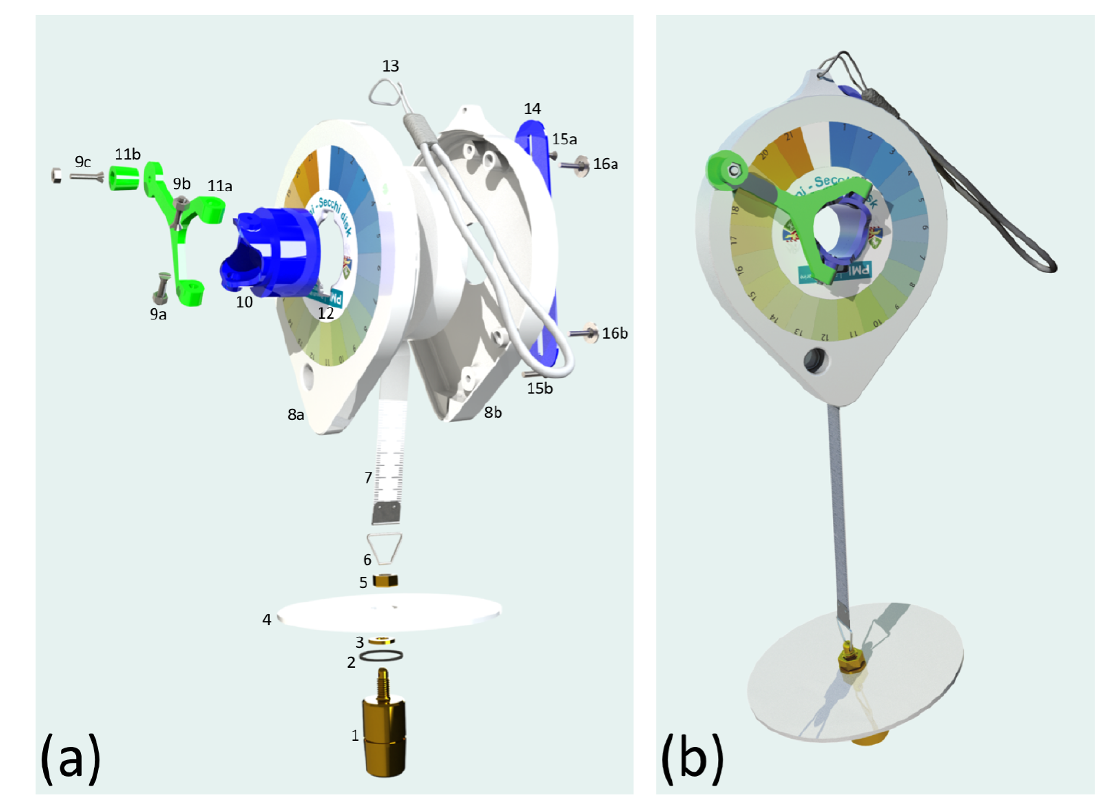
Figure 2. An exploded drawing ( a ) and rendering ( b ) of the mini-Secchi disk. Numbers refer to components (see Table 1 for description) and are listed as follows: 1. Weight; 2. Weight